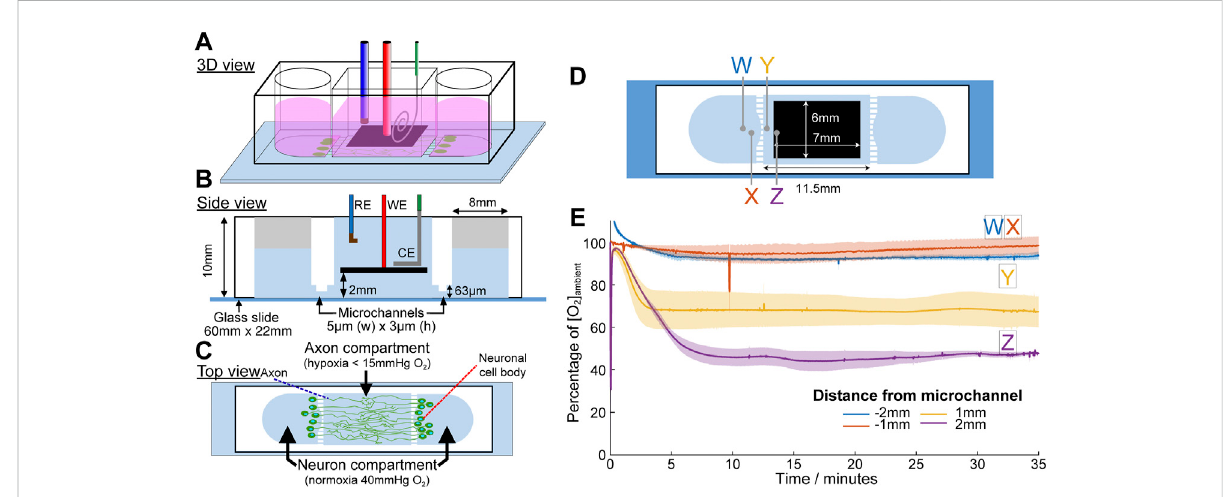
FIGURE 9 Microchannel device designed for the application of acute focal hypoxia in the human cortical brain model. Schematic diagrams for the device at 3D view (A) , side view (B) and top view (C) . Oxygen is only scavenged from the middle chamber where only axons are allowed to grow into. (D) Positions of the oxygen concentration measured were indicated by crosses in the respective colours. (E) Plot of oxygen concentration at different positions under eLOS, measured by a gold